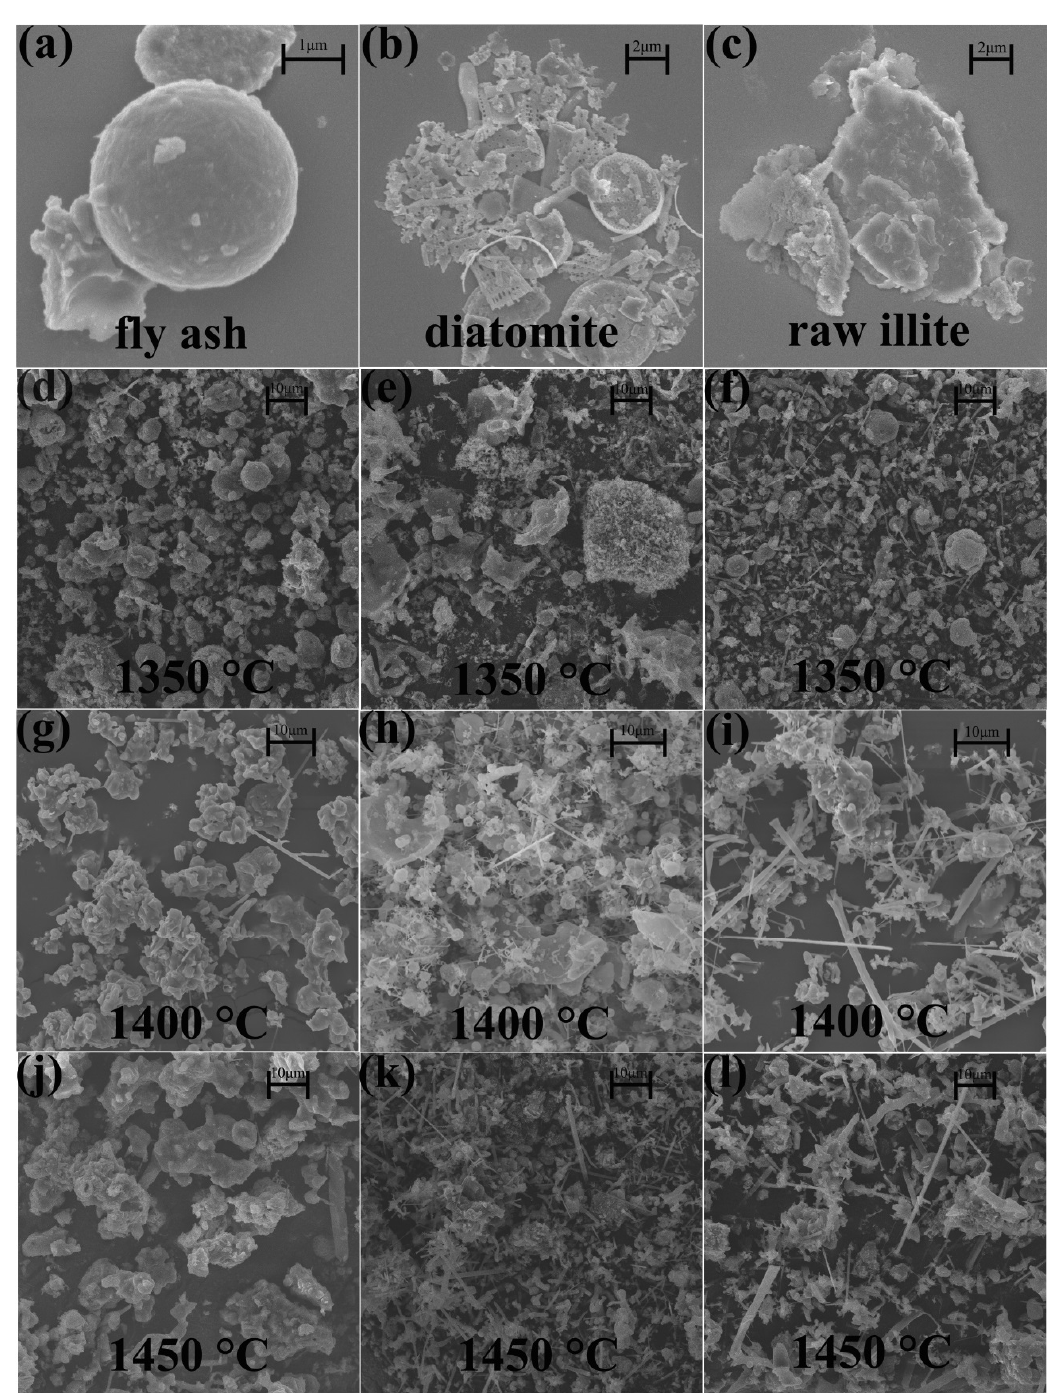
Figure 6. The SEM images of ( a ) pulverized coal furnace fly ash, ( b ) diatomite, ( c ) raw illite, ( d ) products from pulverized coal furnace fly ash at 1350 °C, (e) products from diatomite at 1350 °C, ( f ) products from raw illite at 1350 °C, ( g ) products from pulverized coal furnace fly ash at 1400 °C, ( h ) products from diatomite at 1400 °C, ( i ) products from raw illite at 1400 °C, ( j ) products from pulverized coal furnace fly ash at 1450 °C, ( k ) products from diatomite at 1450 °C and (l) products from raw illite at 1450 °C.